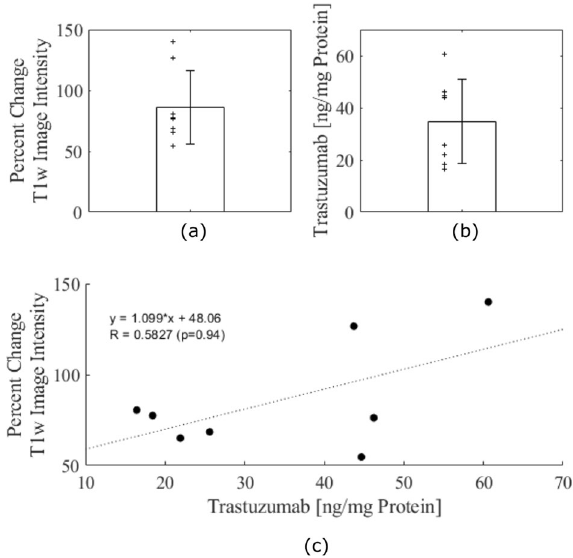
Figure 5. Comparison in healthy rats sacrificed 2 h post-FUS of the percent change in MR enhancement in post-FUS gadolinium enhanced T1w images and trastuzumab concentration. ( a ) Bar graph of average percent change in T1w image intensity following FUS in rats sacrificed at 2-h post-FUS. Individual data plotted as ‘ + ’ scatter points. ( b ) Bar graph of average trastuzumab concentration in ng/mg at 2-h post-FUS. Individual data plotted as ‘ + ’ scatter points. ( c ) Linear regression of trastuzumab concentration and percent change in T1w MR image intensity. Poor correlation is seen (R = 0.5827; p = 0.94). Error bars show standard